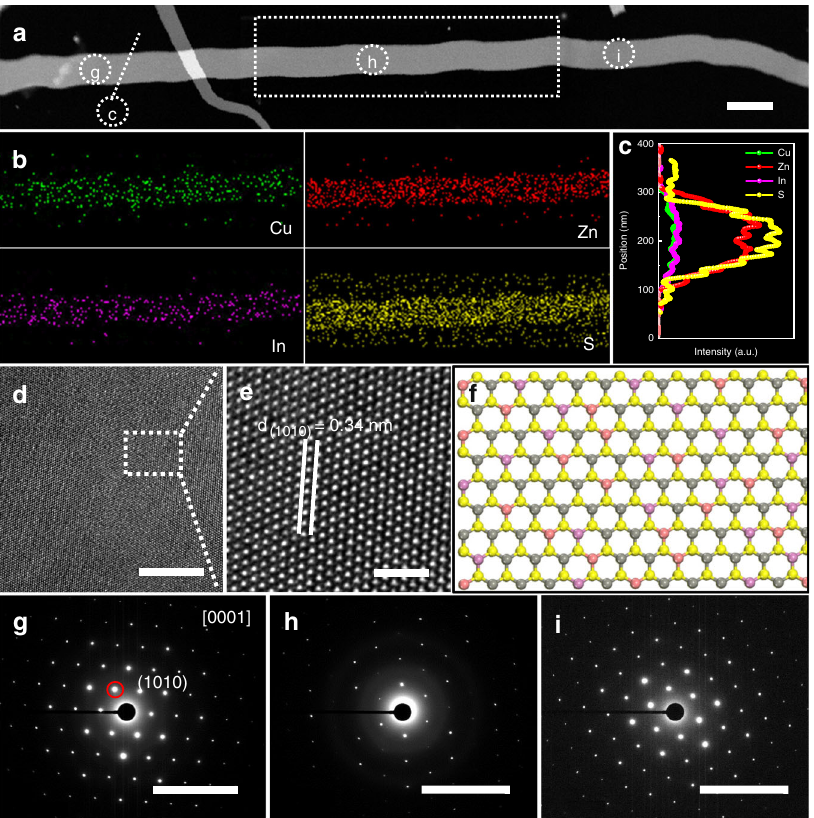
Fig. 2 Characterization of the synthesized wurtzite CZIS nanobelts. a HAADF-STEM image of a typical CZIS nanobelt. b EDS mapping of the selected part in a . c Smoothing simulation EDS-line scan analysis of the selected area in a . d , e HRTEM images. f Crystal model of (0001) facet of wurtzite CZIS nanobelts. g – i SAED pattern of the selected parts in a . Scale bars are 200 nm for a , 10 nm for d , 2 nm for e , 10 1/nm for g – i ,